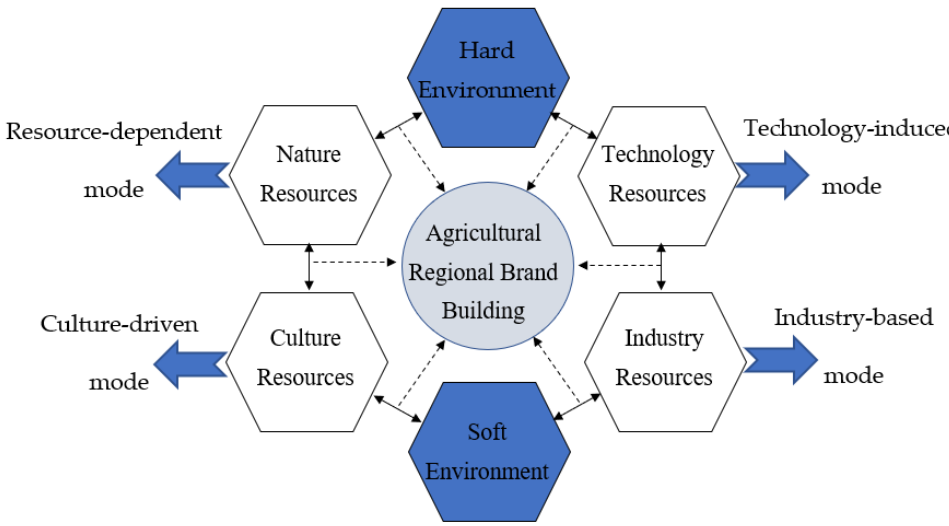
Figure 2. Theoretical model of the agricultural product regional brand-driving mode.